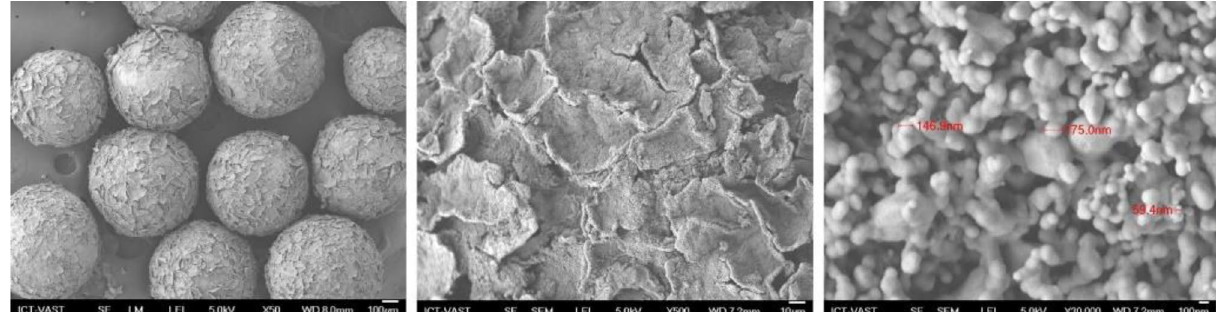
Figure 4. SEM images of resin@ P-Ag 2 O material at different resolutions.